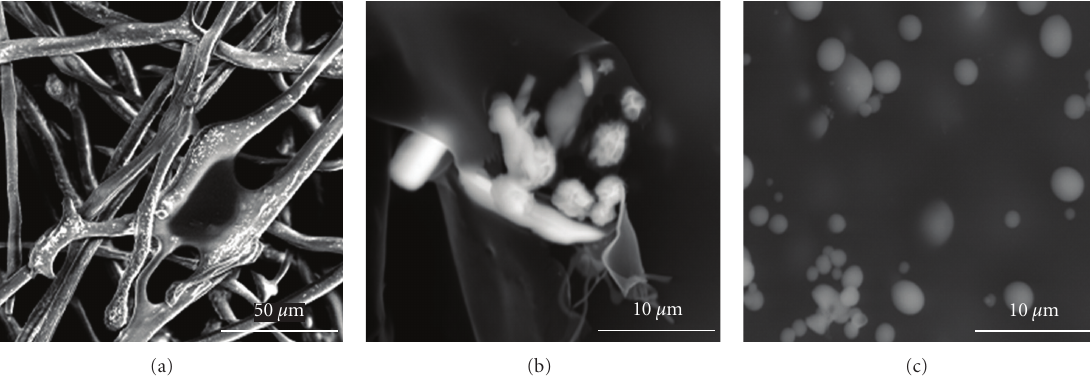
Figure 2: Morphology of obtained polymers; the scanning electron microscopy images: (a) pNIPAM-A, (b) pNIPAM-B, (c) pNIPAM-C.